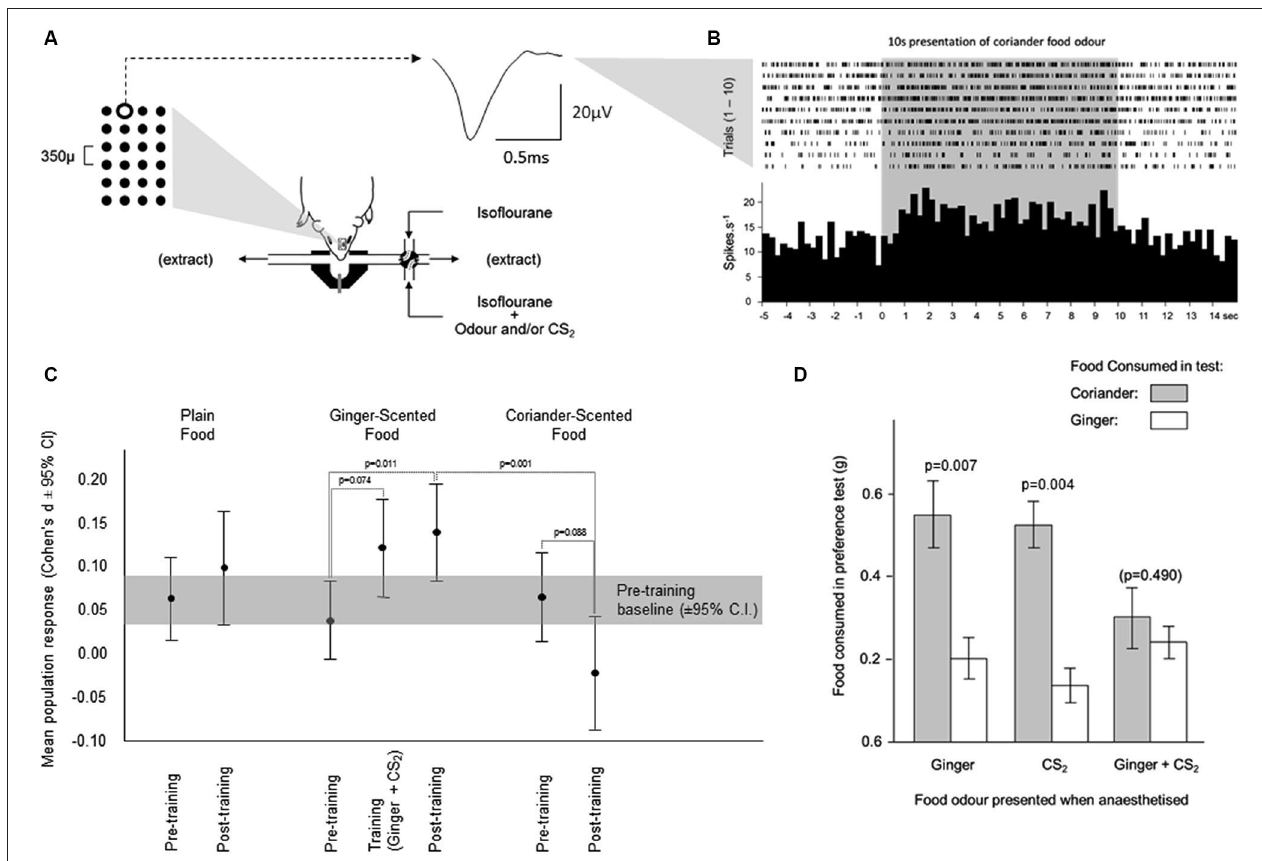
FIGURE 3 | Changes in neuronal activity during olfactory learning under anesthesia. (A) Neuronal activity was sampled from neurons across a 6 × 4 array of tungsten microelectrodes (tip separation 350 µ ) advanced into the olfactory bulb from the dorsal surface. Spikes from individual neurons were sorted from multineuronal activity at multiple channels across the array. The averaged waveform is shown for spikes generated by a single neuron at the position highlighted on the array. Odors were presented for 10 s, by switching the normal anesthetic gas supply with one carrying an odor. (B) The times of occurrence of spikes generated by the neuron depicted in (A) are shown during presentations of the coriander food odor. The histogram shows the average response across 10 presentations of this odor. (C) Each odor was presented 10 times before training, and 10 times after